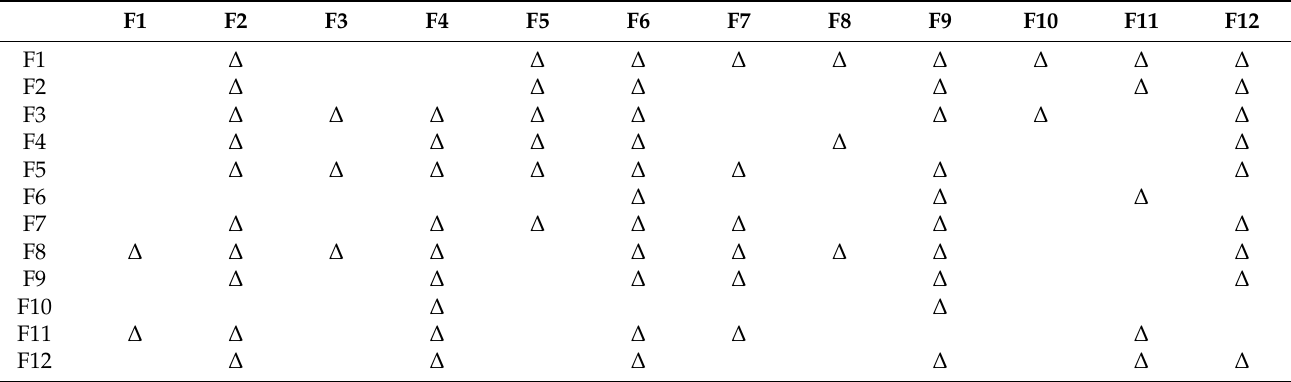
Table 13. Interaction matrix of factors.